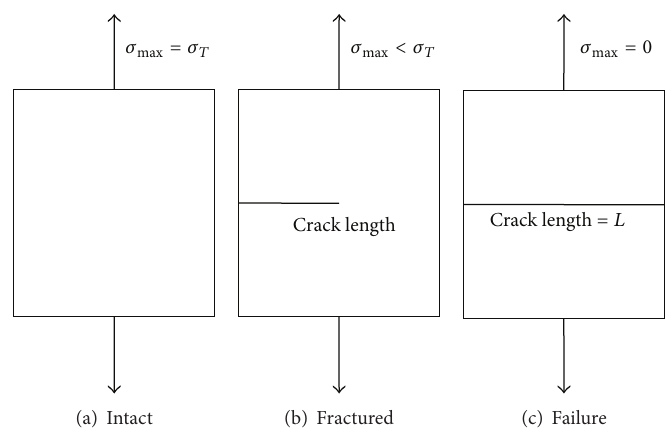
Figure 2: The maximum tensile stress varies with crack propagation.